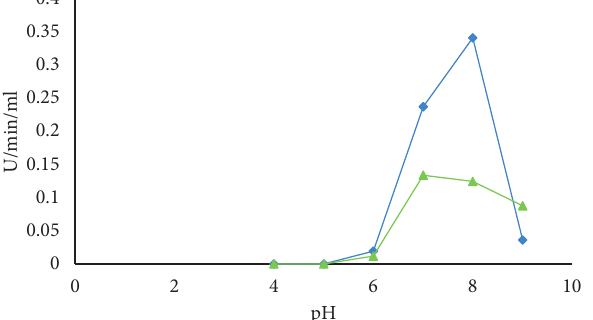
Figure 10: pH stability for B. licheniformis (blue) and B. cereus